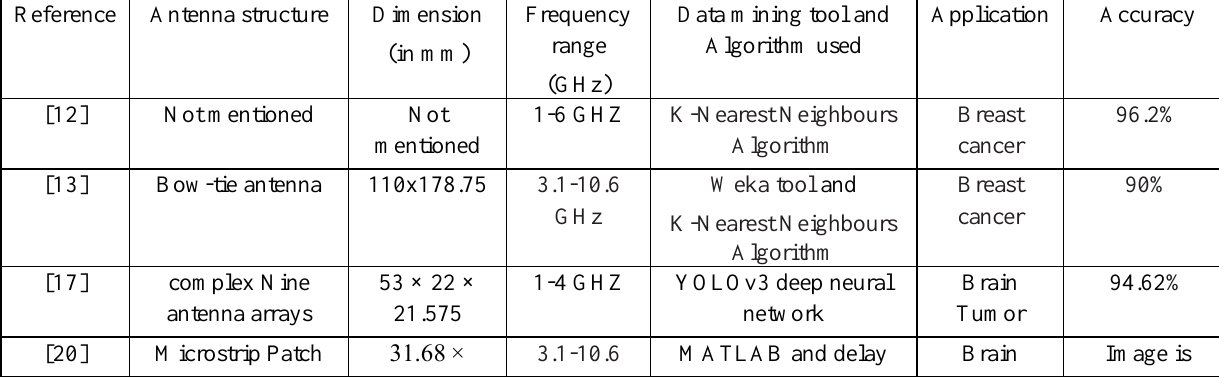
TABLE V. Performance comparison of different Microwave Imaging System reported in literature